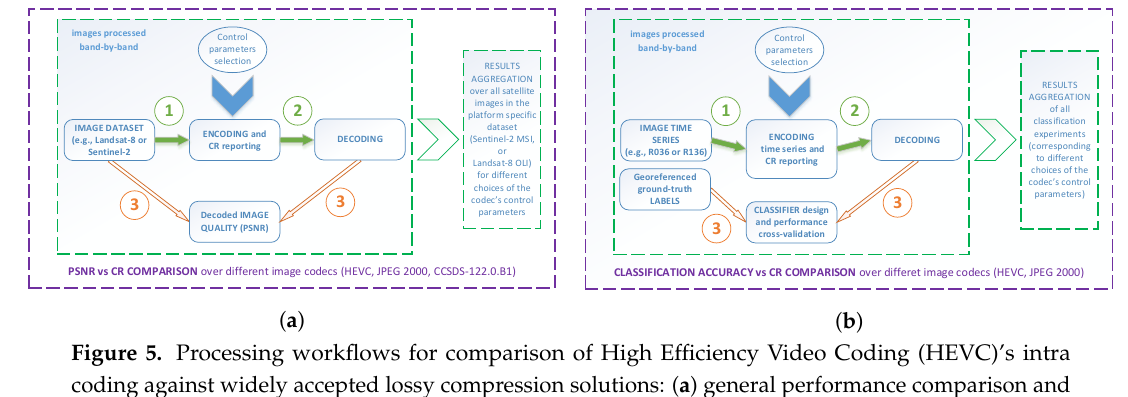
Figure 5. Processing workflows for comparison of High Efficiency Video Coding (HEVC)’s intra coding against widely accepted lossy compression solutions: ( a ) general performance comparison and ( b ) application oriented